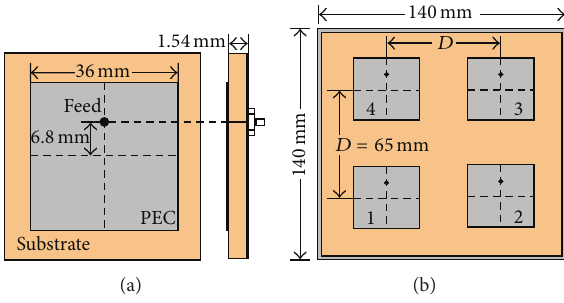
Figure 2: Basic structure and dimensions of antenna element (a) and layout of the array antenna (b).